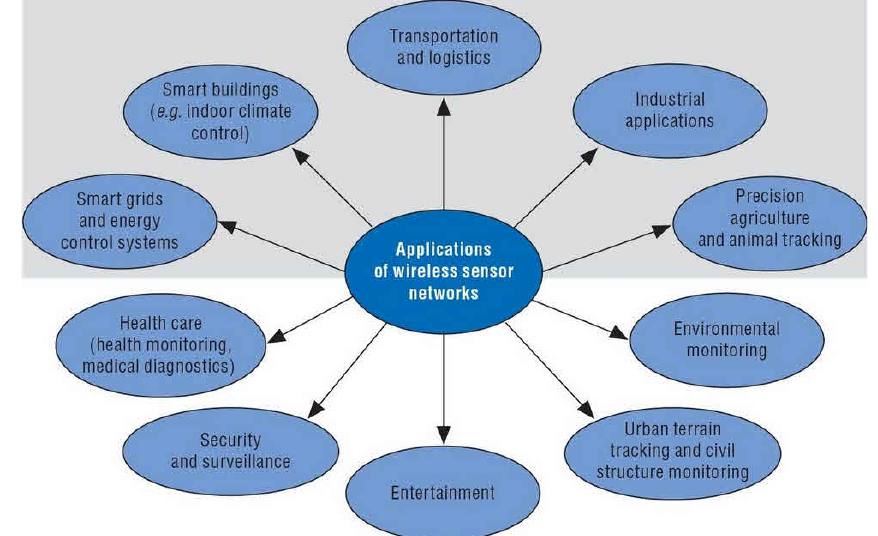
Figure 3. Applications of wireless sensor